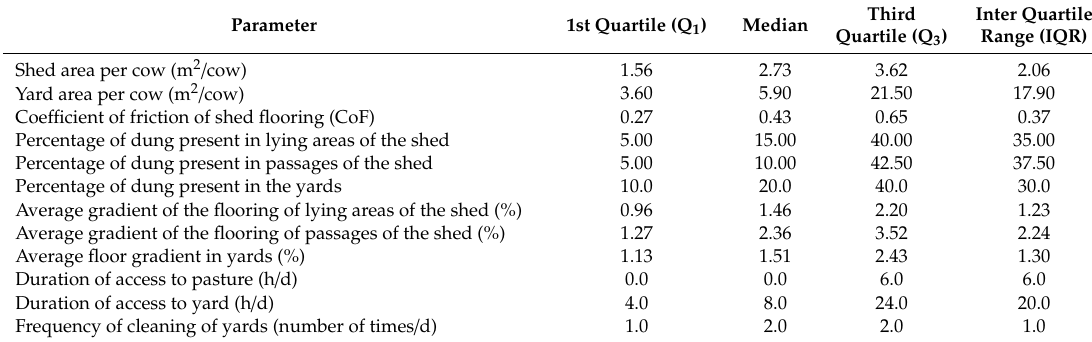
Table 5. Descriptive statistics of resource-based welfare parameters of cow shelters (n =